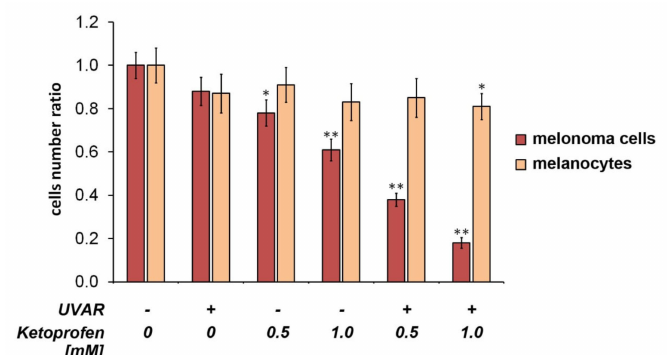
Figure 1. Impact of KTP and UVAR on the growth of COLO829 human melanotic melanoma cells and human melanocytes. The cells were treated with KTP at concentrations of 0.5 mM and 1.0 mM and then exposed to UVAR. The results are presented as the cell number ratio. * p < 0.05, ** p < 0.001 vs. control (one-way ANOVA, two-way ANOVA, Tukey’s test).